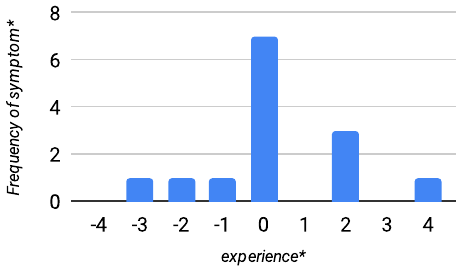
Fig. 5 Distribution of lemma of SYMPTOM with respect to conjugations of verb at node = 0. Verb experience with symptom in English core corpus, standard deviation from mean, μ = 0.86, σ = 2.59. Starred items denote noun and verb forms rather than tokens.